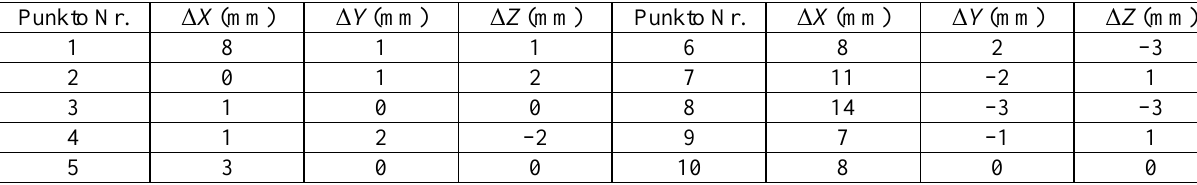
Table 1. Changes of benchmark coordinates Punkto Nr.